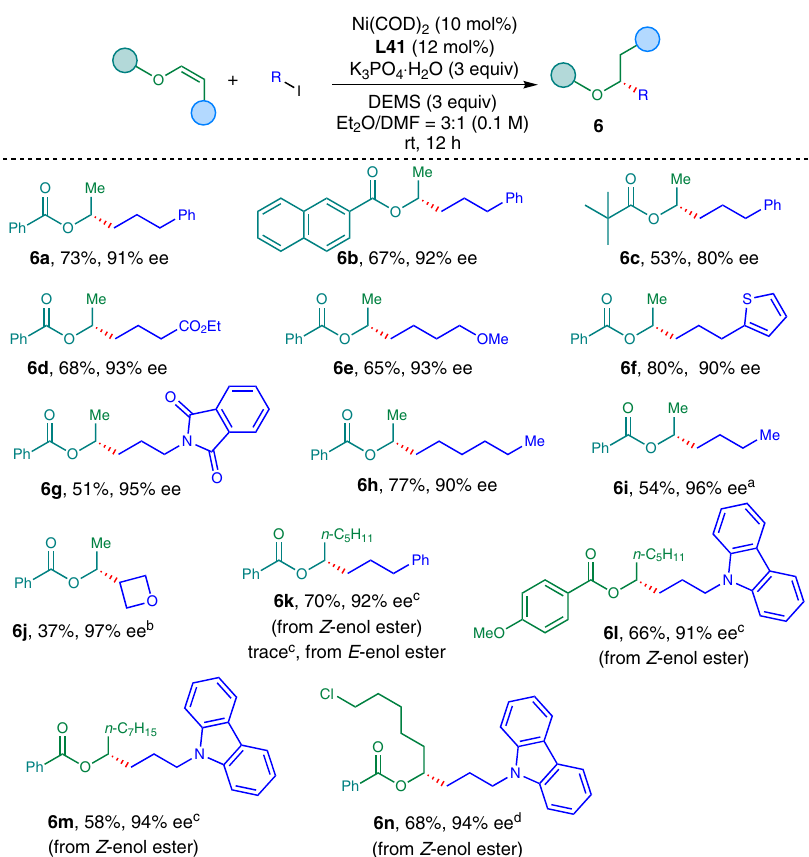
Fig. 5 Scope for the hydroalkylation of enol esters. The reaction was conducted on 0.2 mmol of enol ester (1.0 equiv.) and alkyl iodide (2.0 equiv.) using potassium phosphate monohydrate (3.0 equiv.) as base in Et 2 O/DMF = 3:1 (0.1 M) at room temperature for 12 h unless otherwise stated. a 5.0 equiv. of RI was used. b 3.0 equiv. of RI was used. c The reaction was conducted using alkyl iodide (3.0 equiv.) and potassium carbonate (3.0 equiv.) as base in Et 2 O/ NMP = 3:1 (0.2 M) at 45 °C for 16 h. d The reaction was conducted using alkyl iodide (3.0 equiv.) and potassium carbonate (3.0 equiv.) as base in the presence of tert -butanol (4.0 equiv.) in Et 2 O/NMP = 3:1 (0.2 M) at 45 °C for 16 h. NMP = N-methyl pyrrolidone.